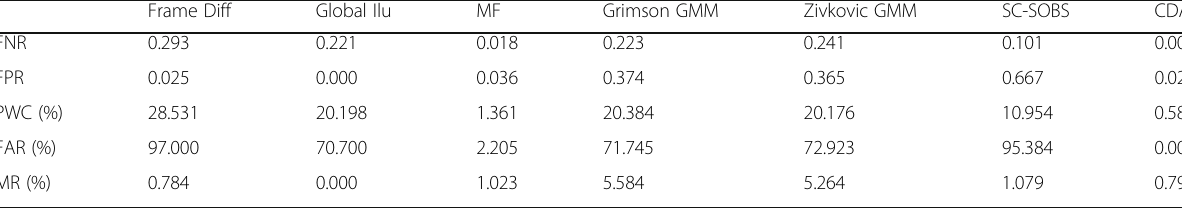
Table 11 Comparison results with the CDnet-2014 “ office ” dataset in a noisy environment Frame